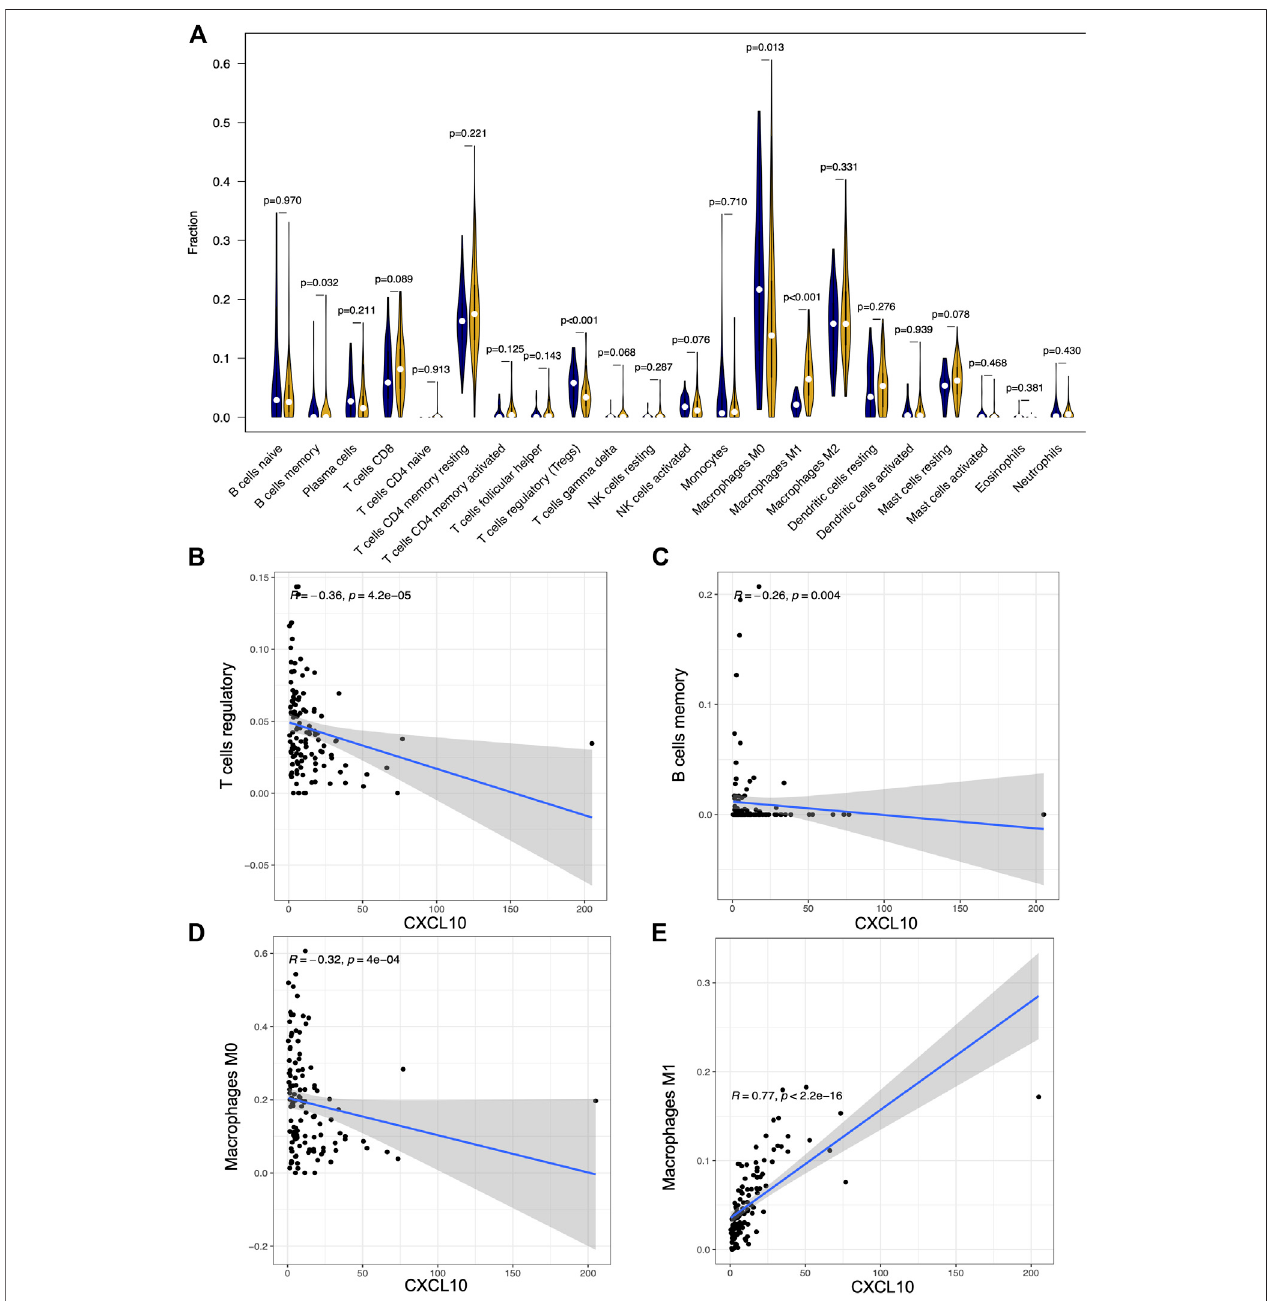
FIGURE 10 | The correlation between the expression of CXCL10 and fractions of tumor in fi ltrated immune cells. (A) Comparisons of 22 kinds of tumor in fi ltrated immune cells between high and low CXCL10 expression groups. The blue violin diagram presented low CXCL10 expression group, and the yellow violin diagram presented high CXCL10 expression group. Wilcoxon rank-sum was used for the signi fi cance test. (B – E) The correlation between tumor in fi ltrated immune cells and the expression of CXCL10. Pearson coef fi cient test was used for the signi fi cance test.